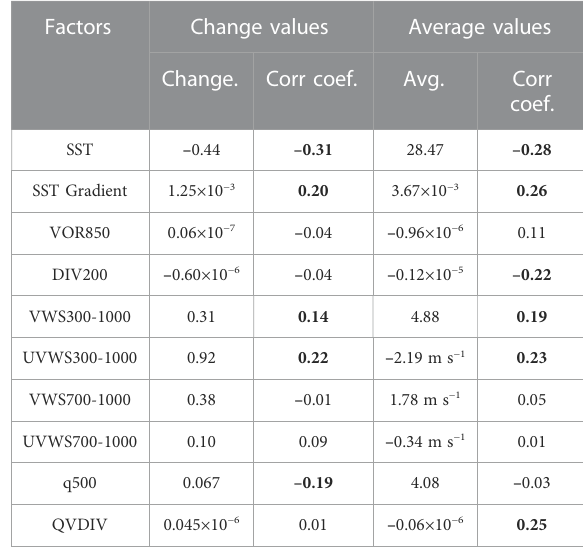
TABLE 2 The average factors and Mann-Kendall correlation coef fi cients with LFDR. Change (T 0h -T -18h ), average values indicate the pre-landfall change and average value,